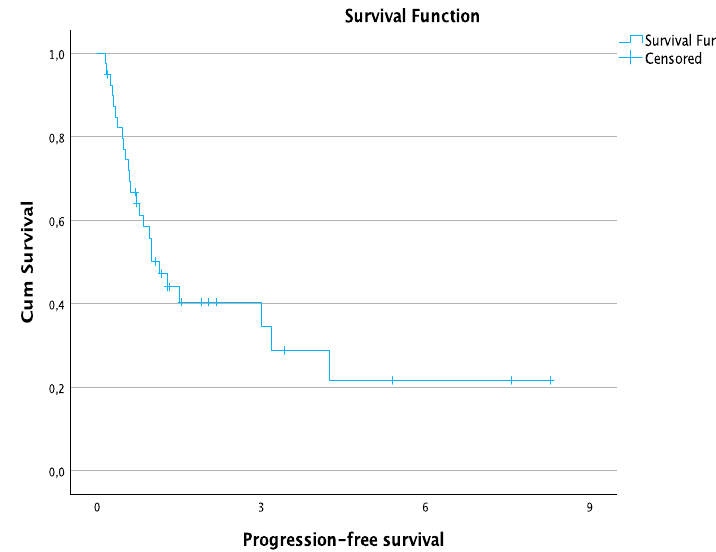
Figure 3. Progression-free survival for all patients in years.